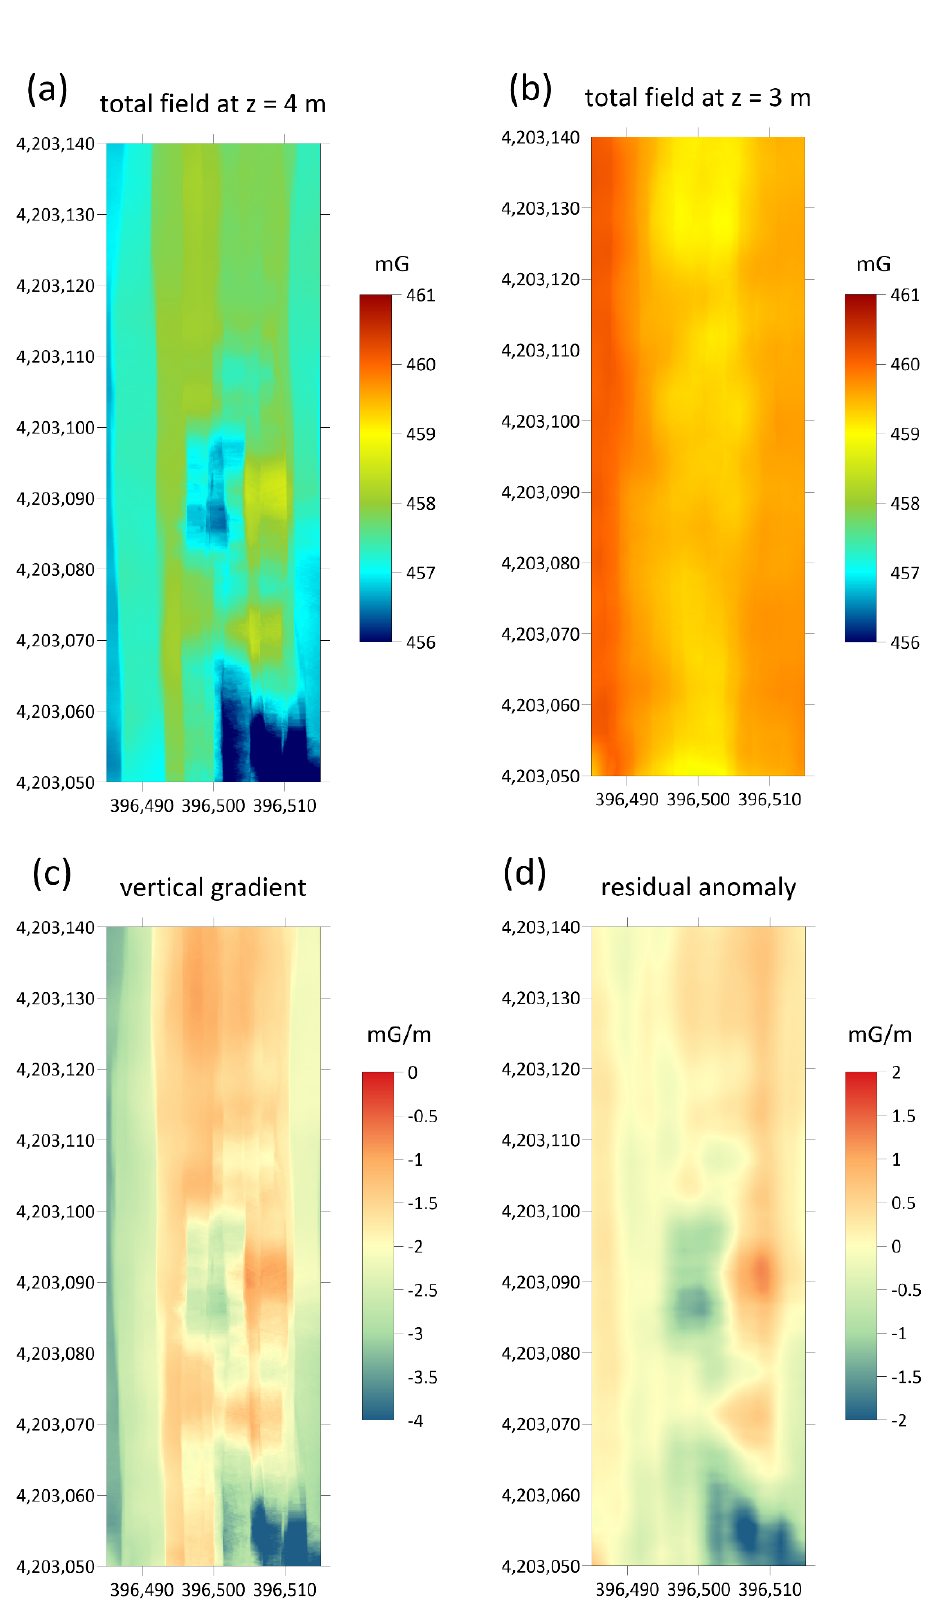
Figure 8. Steps for the calculations of the residual gradiometric anomaly related to the area covered by the second test. ( a , b ) Maps of the total magnetic field surveyed with the sensor at 4 and 3 m above ground level, respectively; ( c ) gradiometric maps resulting from the differences between the two maps; ( d ) residual anomaly after removing the background magnetic signal. Projected coordinates referred to UTM zone 33. Units of the magnetic field are in milligauss.